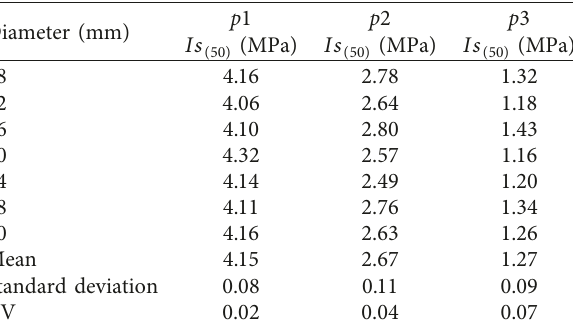
Table 3: Is ( 50 ) of the cylinder